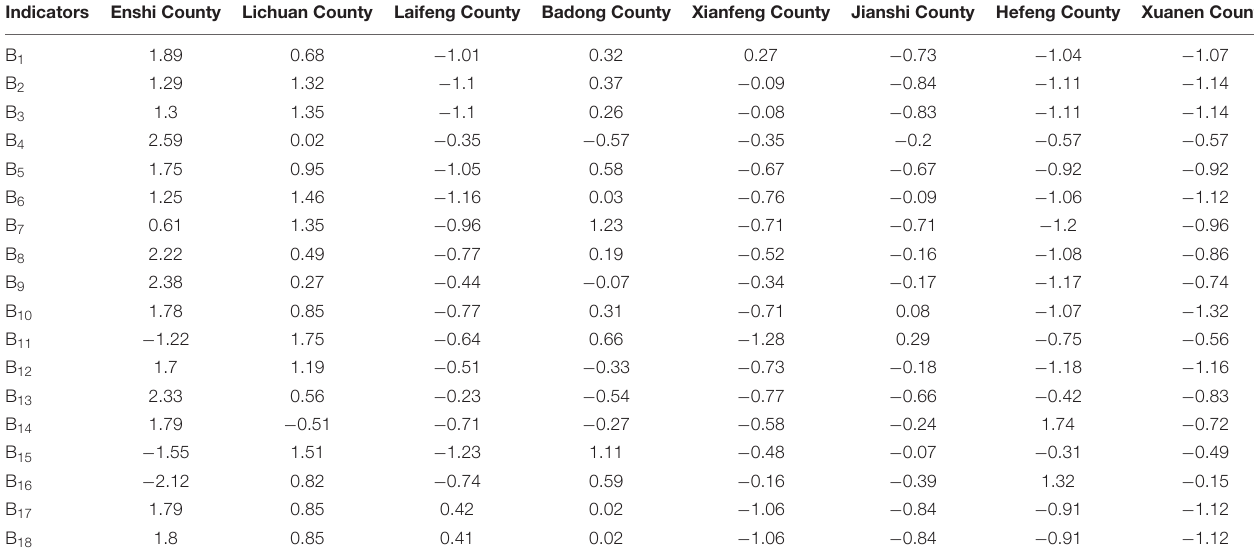
TABLE 3 | Standardized results of EAP mountain tourism competitiveness